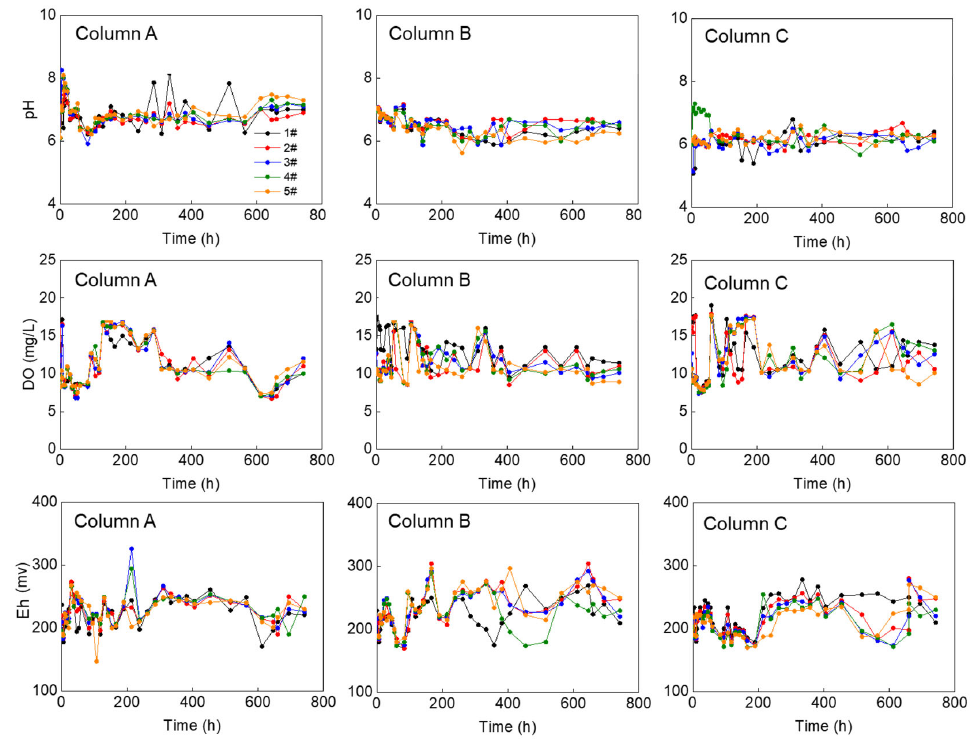
Figure 2. Changes of the pH, DO concentration, and Eh with